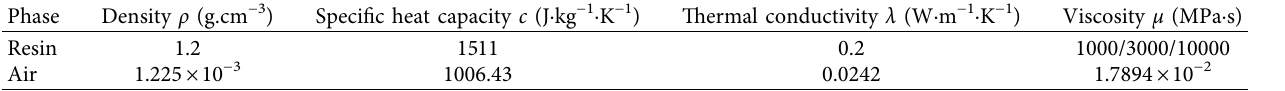
Table 1: Material properties in fluid